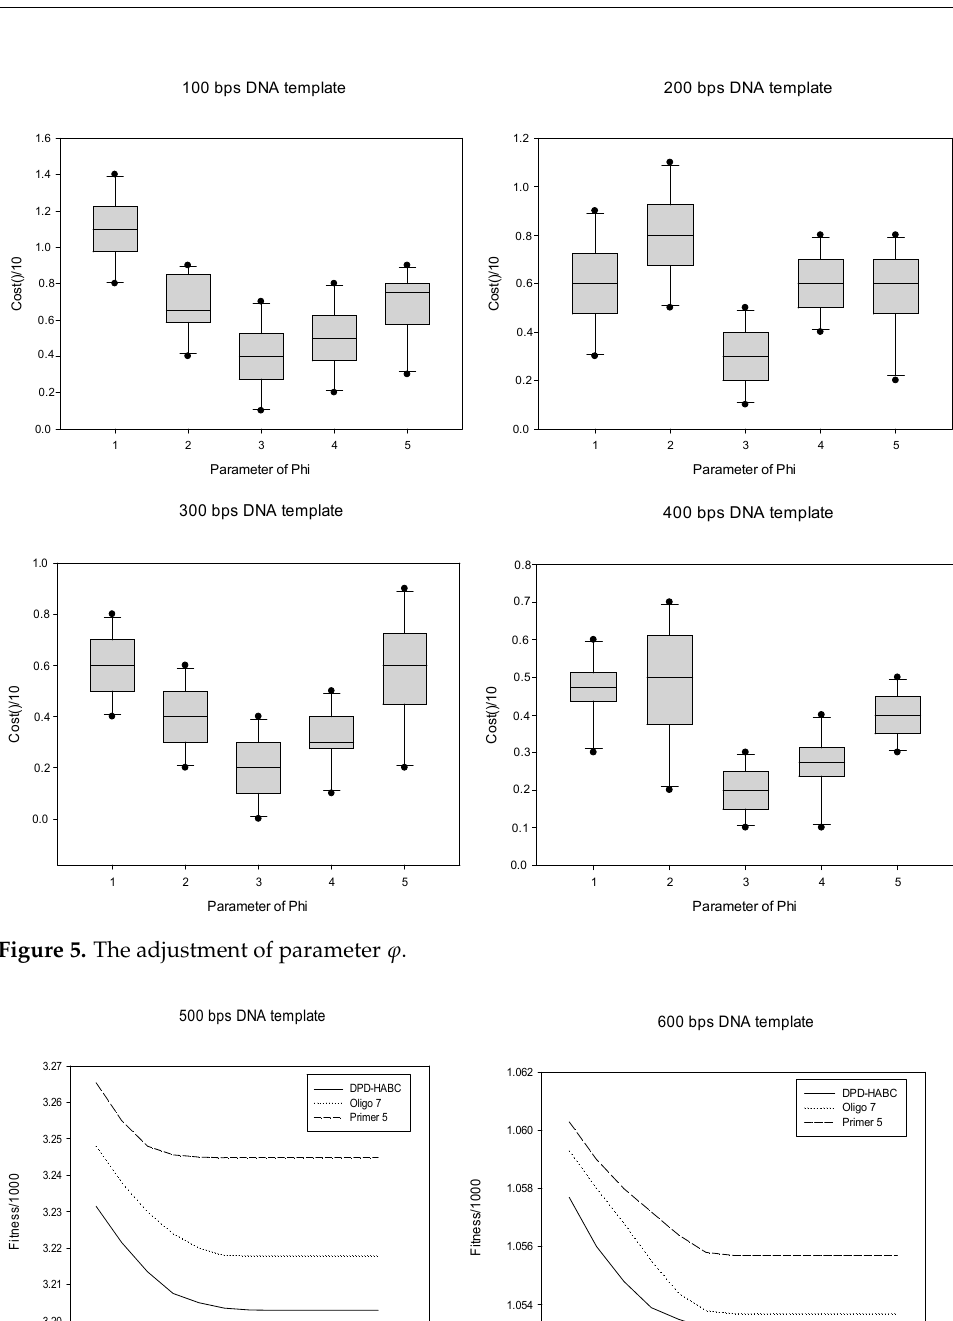
Figure 6. Convergence graphs for DPD.